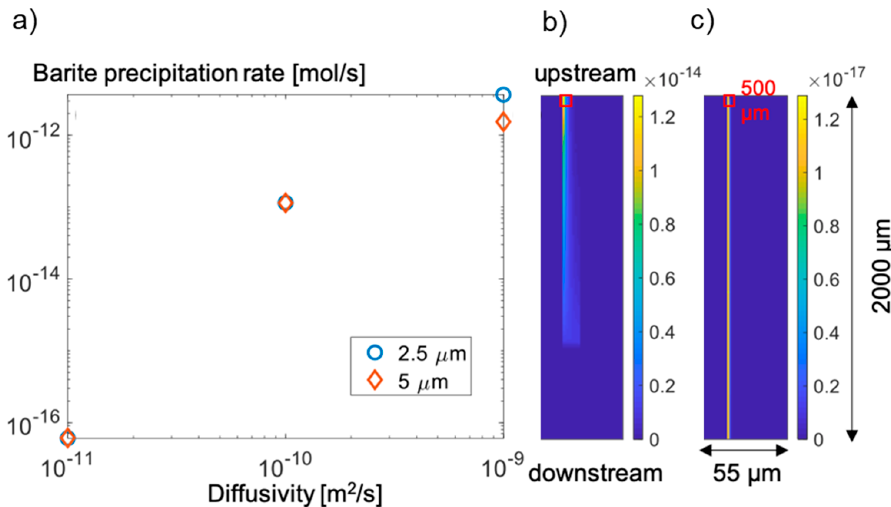
Figure 9. ( a ) Barite precipitation rate as a function of the effective diffusivity of the coating layer assuming a thickness of 2.5 µm and 5 µm, ( b ) barite precipitation rate simulated with a diffusion coe ffi cient of 1 × 10 − 10 m 2 s − 1 and a layer thickness of 5 µ m leading to high barite precipitation coefficient of 1 × 10 − 10 m 2 s − 1 and a layer thickness of 5 µm leading to high barite precipitation rate and no precipitation downstream, and ( c ) barite precipitation rate simulated with a diffusion coefficient of 1 × 10 -11 m 2 s − 1 and a layer thickness of 5 µm leading to low barite precipitation rate all over the considered section (See also Figure 2). The red box in (b) and (c) highlights the region used to calculate the barite precipitation rate presented in (a).